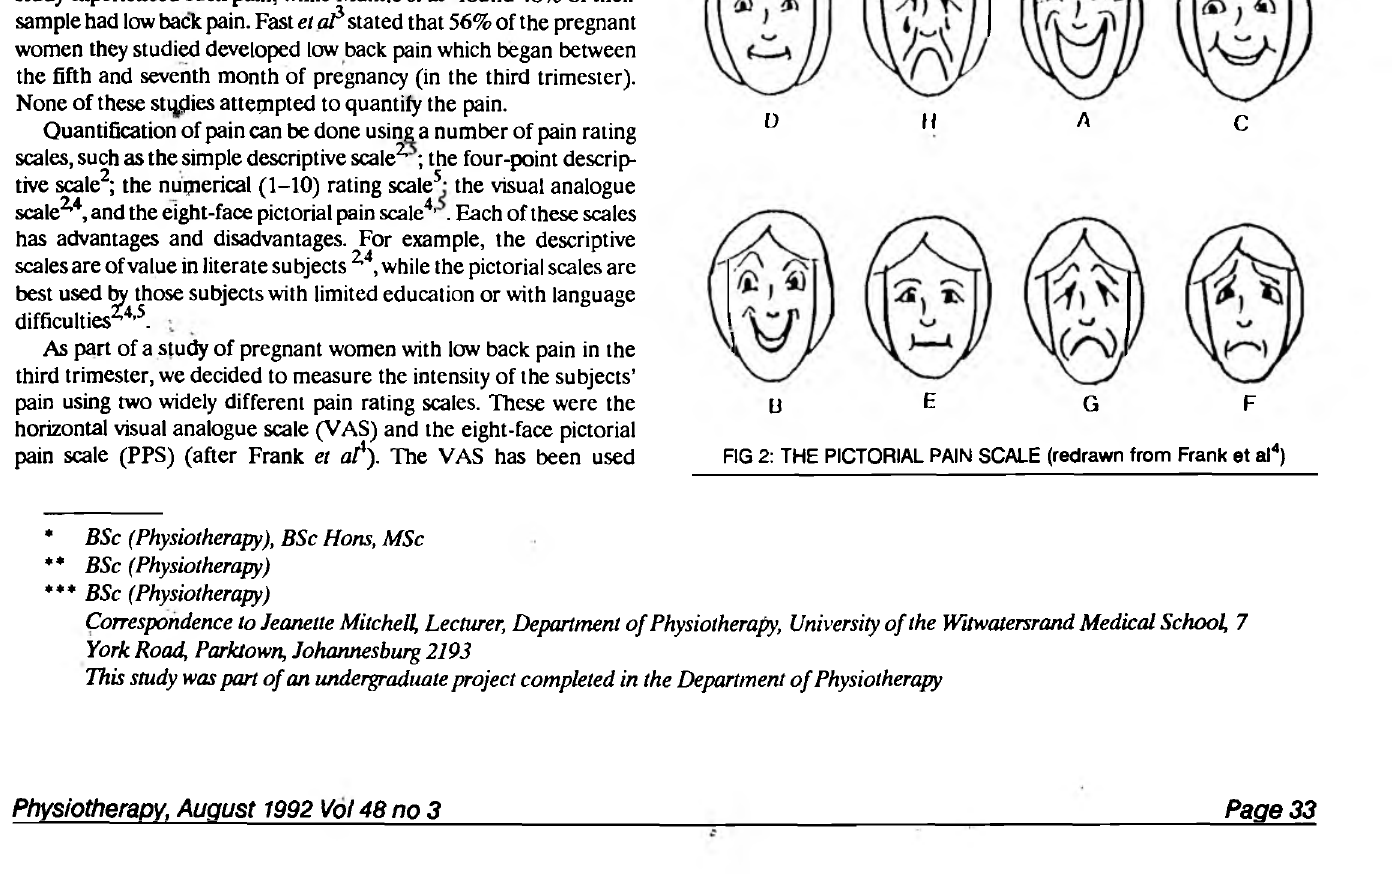
FIG 2: THE PICTORIAL PAIN SCALE (redrawn from Frank